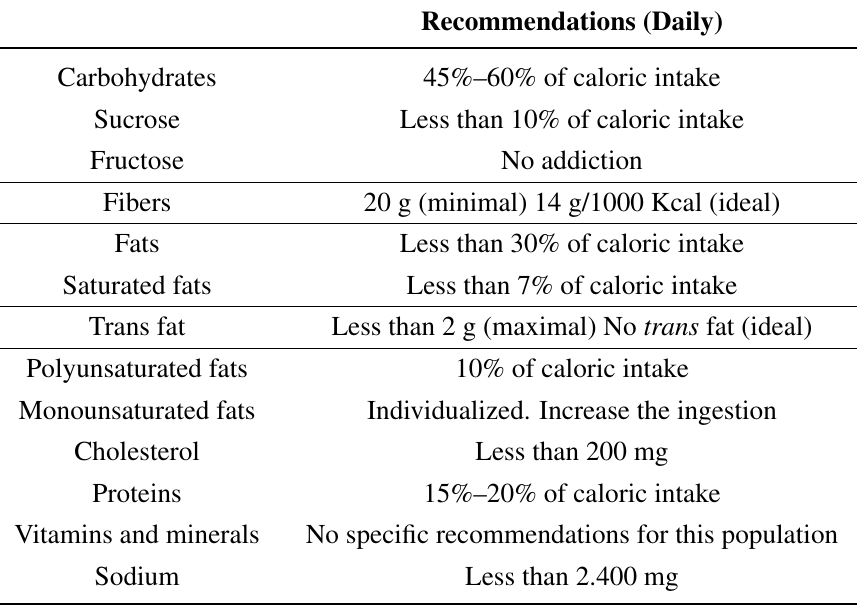
Table 6. Nutritional Guidelines for T2D by Brazilian Diabetes